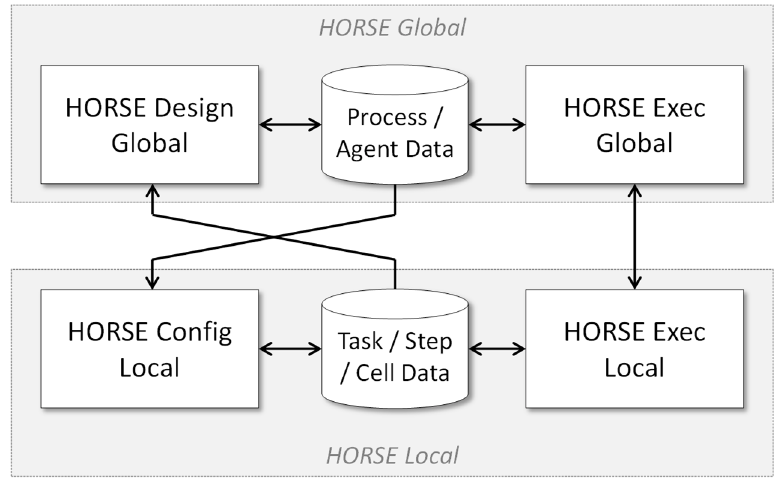
Figure 6. HORSE architecture, aggregation level 1.